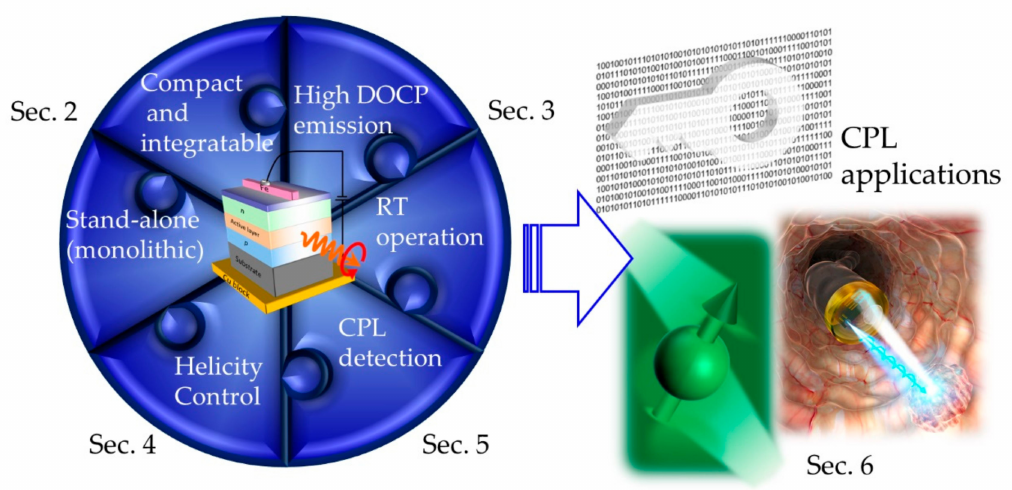
Figure 1. Schematic outline of this review with the corresponding section number. ( Left ) Requirements for practical CPL use with LT-spin-LED at the center. ( Right ) CPL applications: Quantum cryptography, holography, and biosensing using CPL,